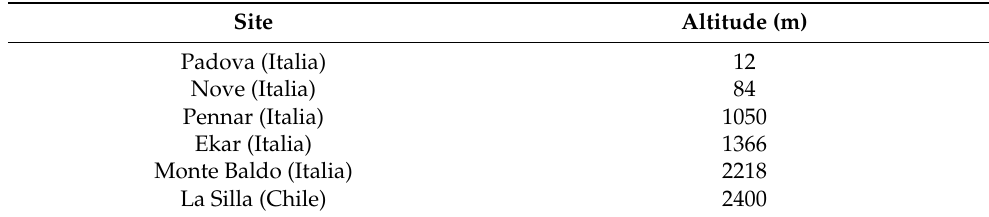
Table 1. List of the considered sites and their